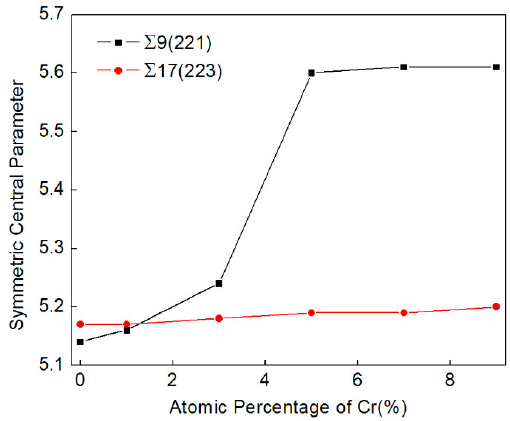
Figure 7. Atomic symmetric central parameters of the Σ9(221) GBs and Σ17(223) GBs in pure Fe and Fe-X at.% Cr alloys (X = 1, 3, 5, 7, and 9).